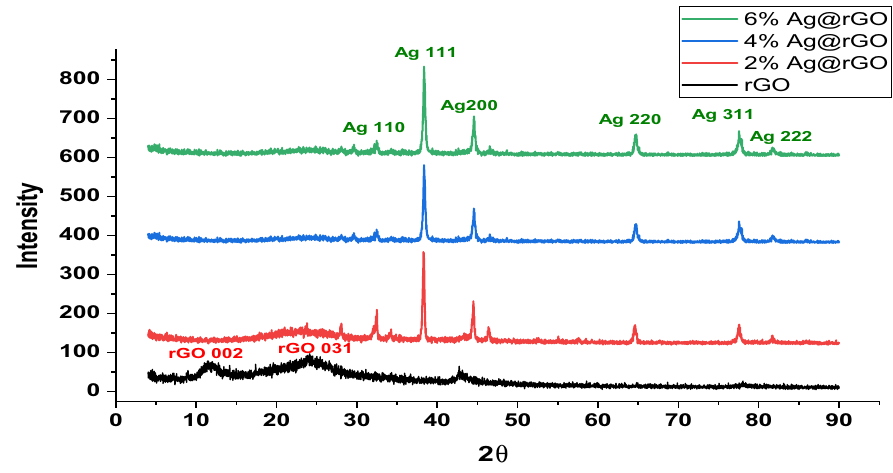
Fig. 3 XRD Spectra of rGO, rGO@Ag 2%, rGO@Ag 4% and rGO@Ag 6% nanocomposite